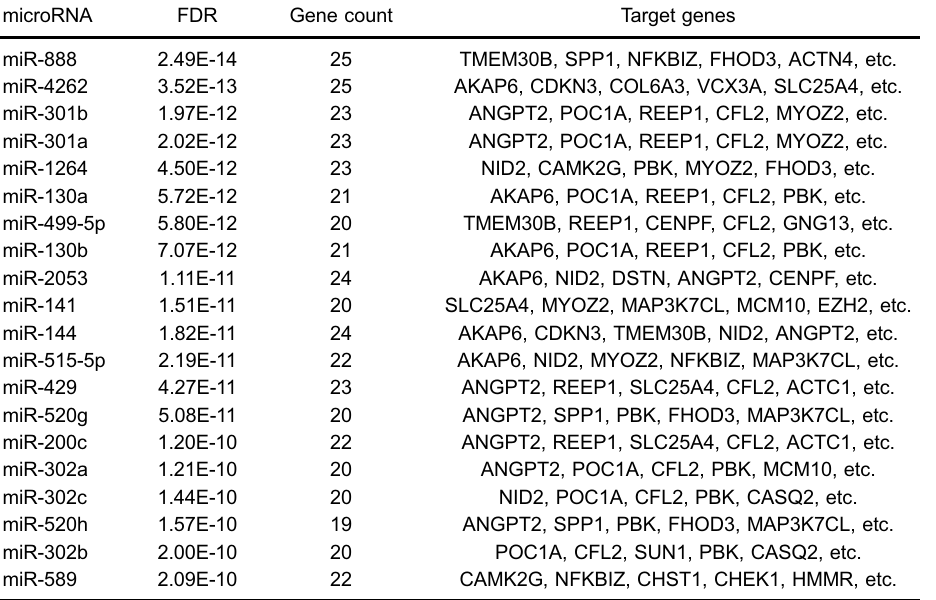
Table 3. Top 20 microRNAs of the differentially expressed